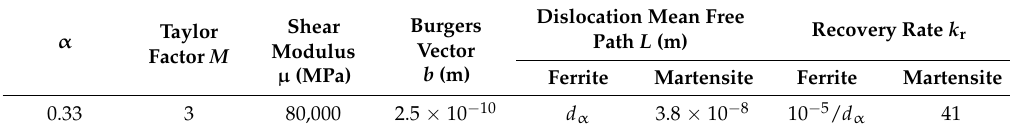
Table 3. Variable values used in Equation